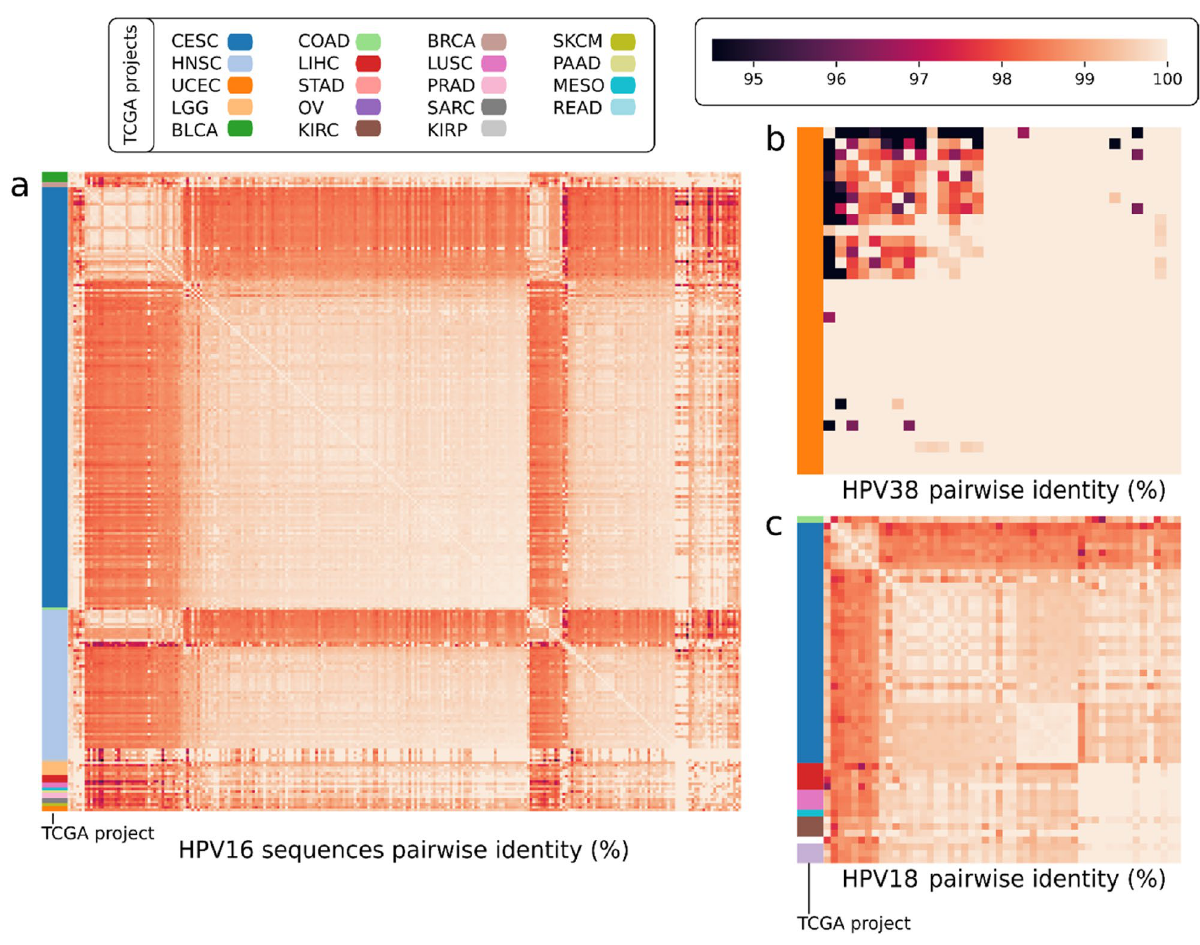
Figure 2. HPV pairwise comparison among HPV positive specimens detected in TCGA. Pairwise comparison performed for HPV16 positive RNA sequences in the TCGA database ( a ), for HPV 38 sequences ( b ) and for HPV 18 sequences ( c ). BLCA: Bladder Urothelial Carcinoma; BRCA: Breast Invasive Carcinoma; CESC: Cervical Squamous Cell Carcinoma and Endocervical Adenocarcinoma; COAD:Colon Adenocarcinoma; HNSC: Head and Neck Squamous Cell Carcinoma; KIRC: Kidney Renal Clear Cell Carcinoma; KIRP: Kidney Renal Papillary Cell Carcinoma; LGG: Brain Lower Grade Glioma; LIHC: Liver Hepatocellular Carcinoma; LUSC: Lung Squamous Cell Carcinoma; MESO: Mesothelioma; OV: Ovarian Serous Cystadenocarcinoma; PAAD: Pancreatic Adenocarcinoma; PRAD: Prostate Adenocarcinoma; READ: Rectum Adenocarcinoma; SARC: Sarcoma; SKCM: Skin Cutaneous Melanoma; STAD: Stomach Adenocarcinoma; UCEC: Uterine Corpus Endometrial Carcinoma. (Image created using Python v. 3.8.10 and Seaborn library v. 0.11.2, https:// seabo rn. pydata.